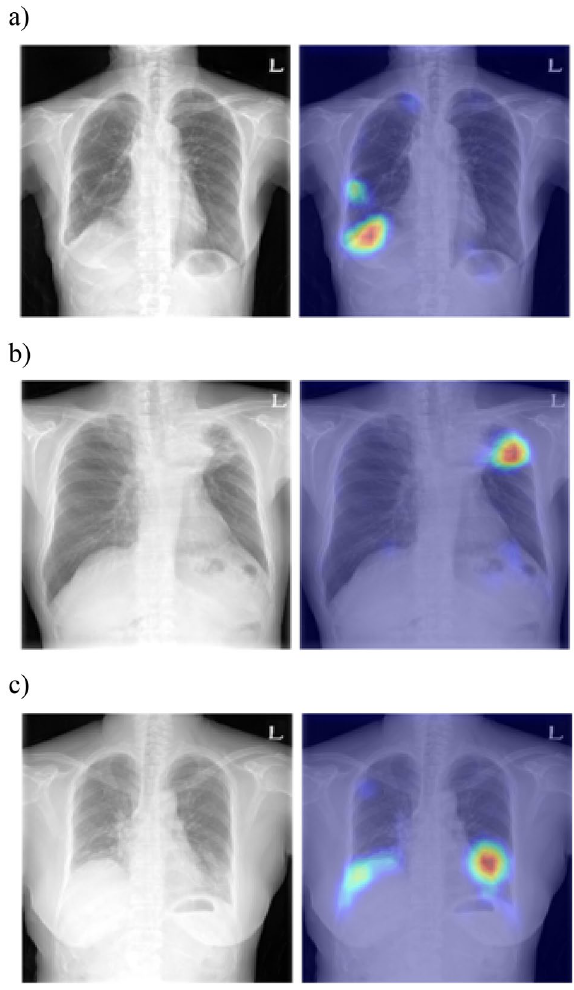
Figure 3. Grad-CAMs of synthetic images in the first Turing test dataset wherein the decisions of all readers are